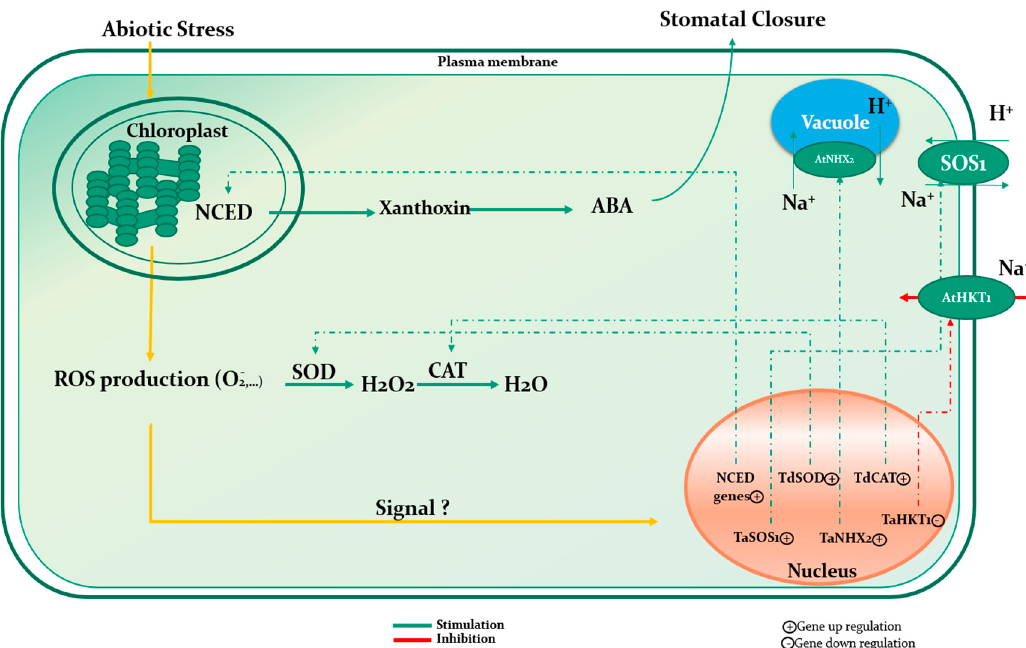
Figure 4. Conceptual illustration highlighting the effect of seaweed extract on the down and up-regulation of some key genes in response to abiotic stress: Seaweed extract application to plants subjected to abiotic stress alter the regulation of ROS scavenging related genes (TdSOD and TdCAT), NCED (9-cis-epoxycarotenoid dioxygenase) related genes, Na + transporter (TaHKT1) and antiporters (TaSOS1 and TaNHX2) genes. Superoxide dismutase (SOD), catalase (CAT), abscisic acid (ABA). Table 2. Effect of seaweed extracts on plants’ gene expression.